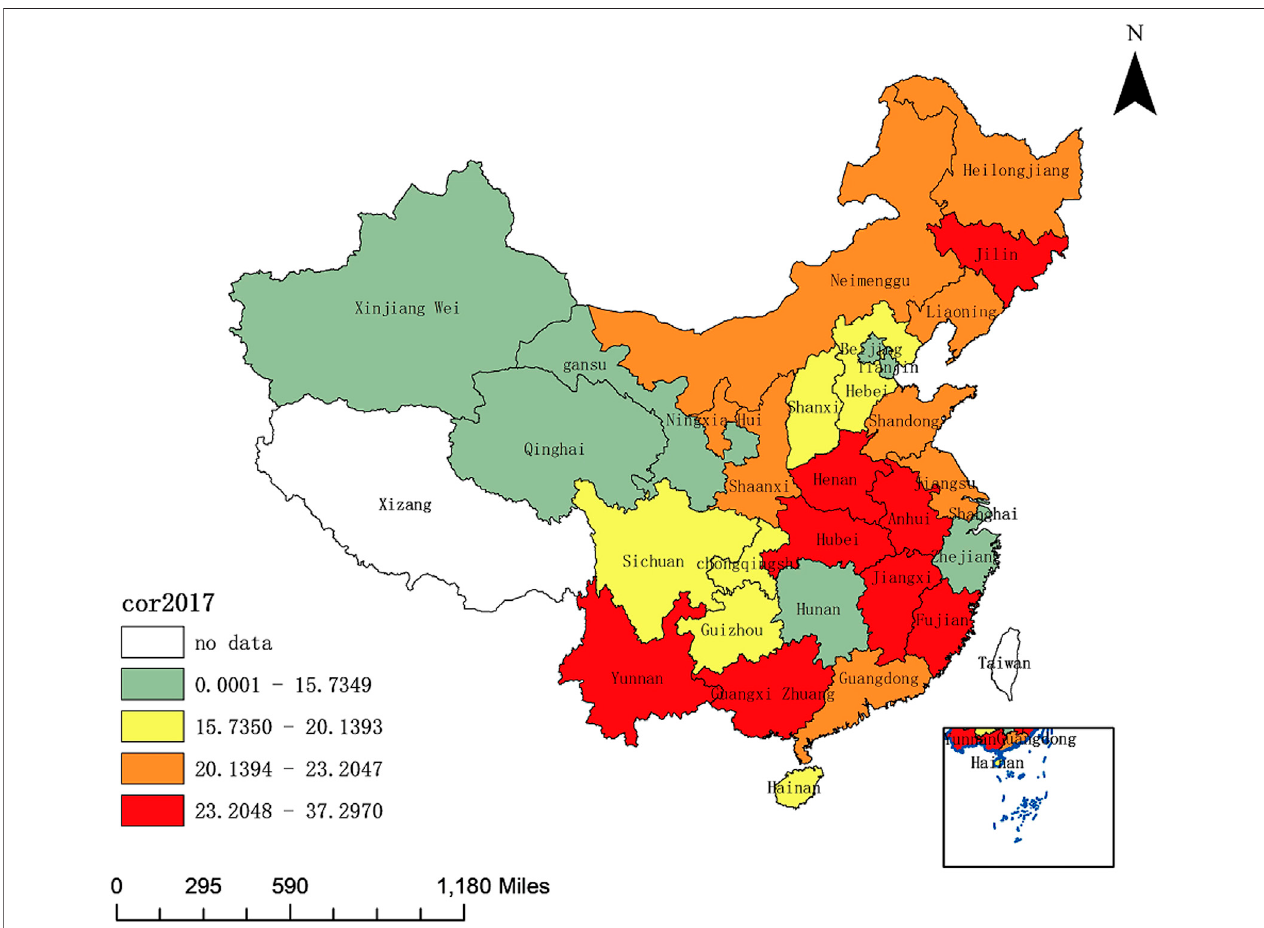
FIGURE 2 | Corruption levels in Chinese provinces in